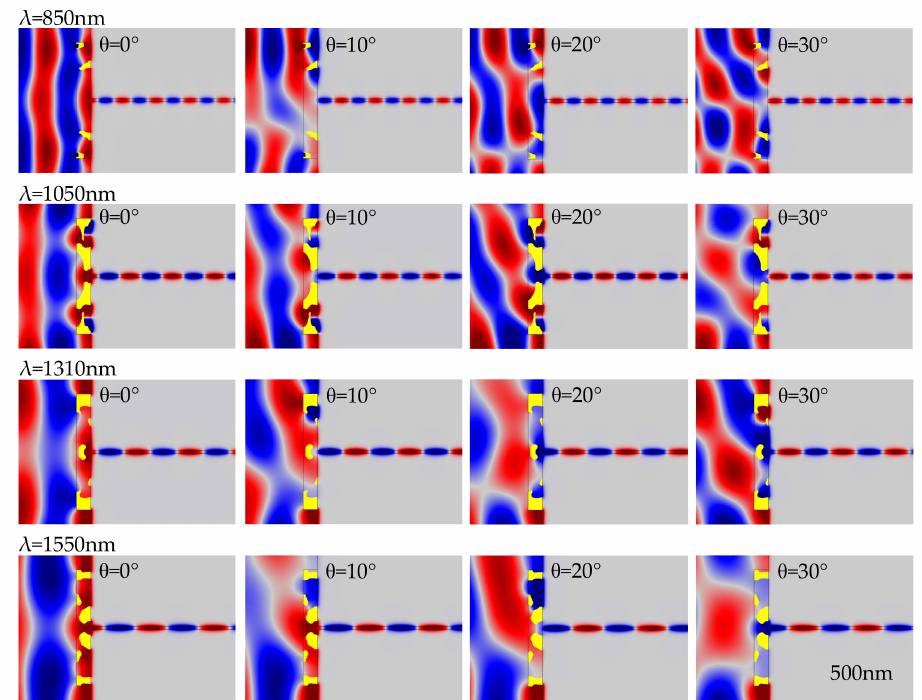
Figure 3. The four derived nanoantennas for the four communication wavelengths, where the specified range for the oblique angles is from − 30 ◦ to 30 ◦ and the distributions of the real part of the magnetic field are plotted for the four oblique angles 0 ◦ , 10 ◦ , 20 ◦ and 30 ◦ .